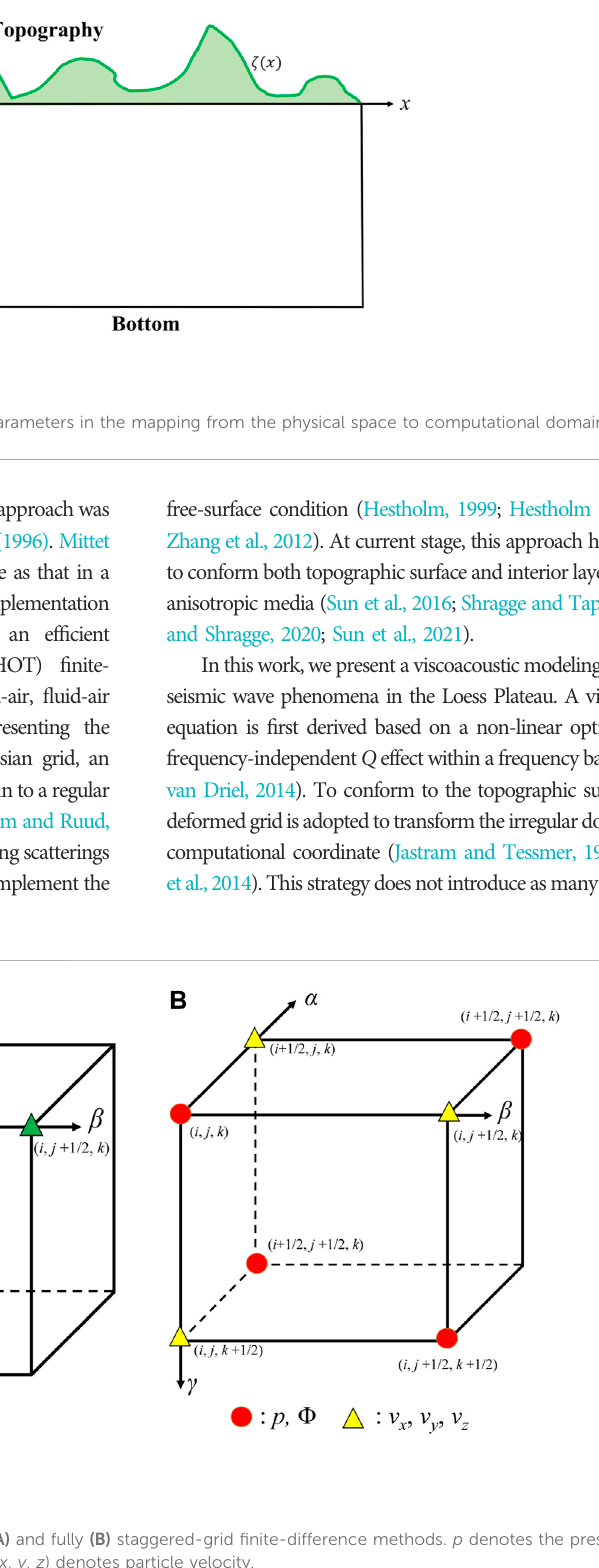
Frontiers in Earth